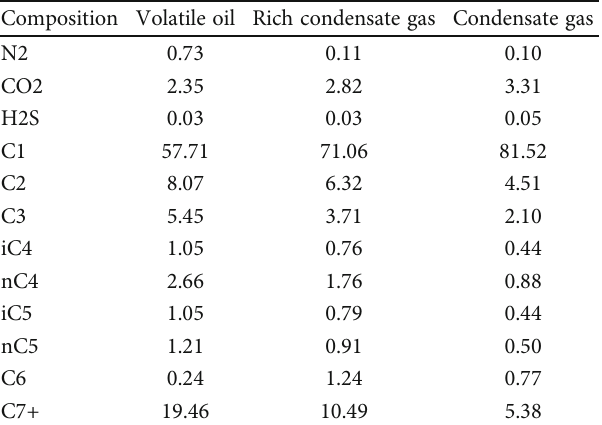
Table 1: Composition content of three fl uid samples. Composition Volatile oil Rich condensate gas Condensate